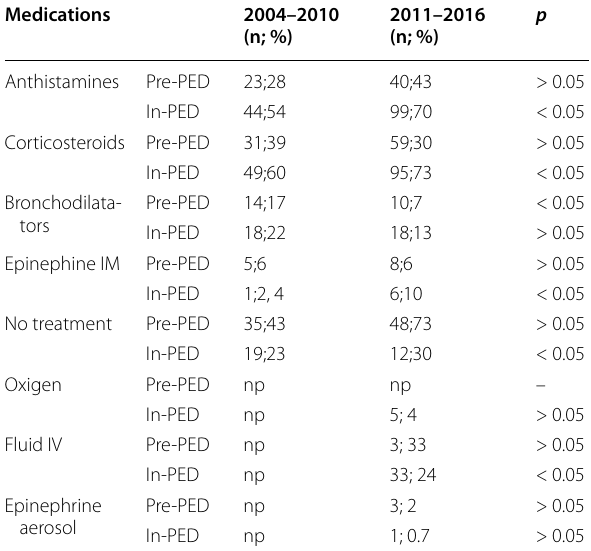
Table 1 Treatment of anaphylactic reaction in PRE‑s and POST‑s